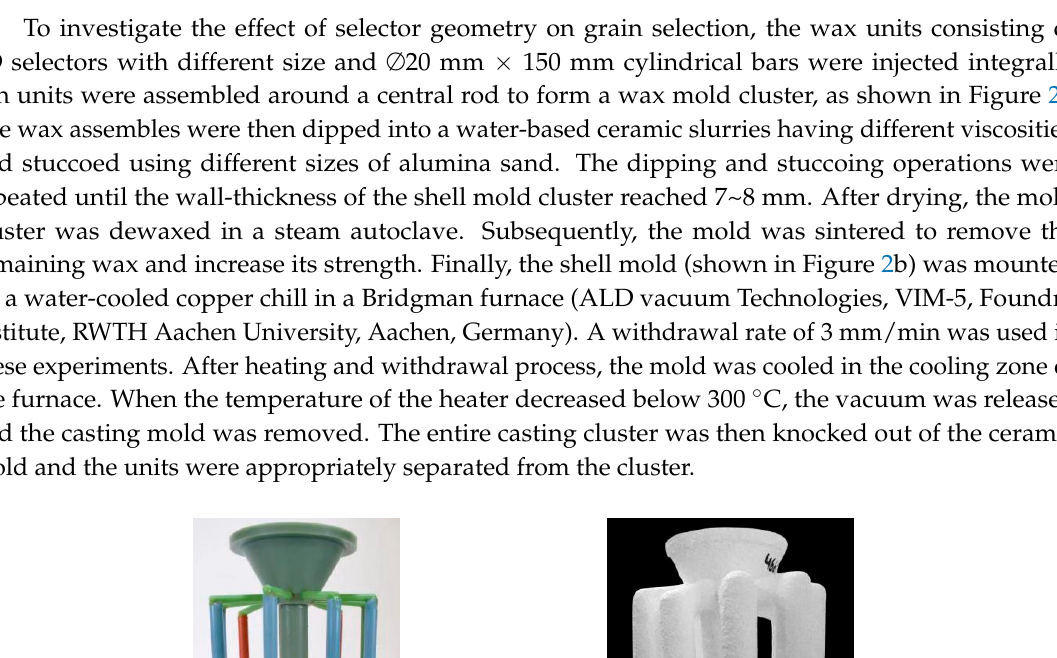
Table 3. The composition of superalloy CM247LC/wt.%.